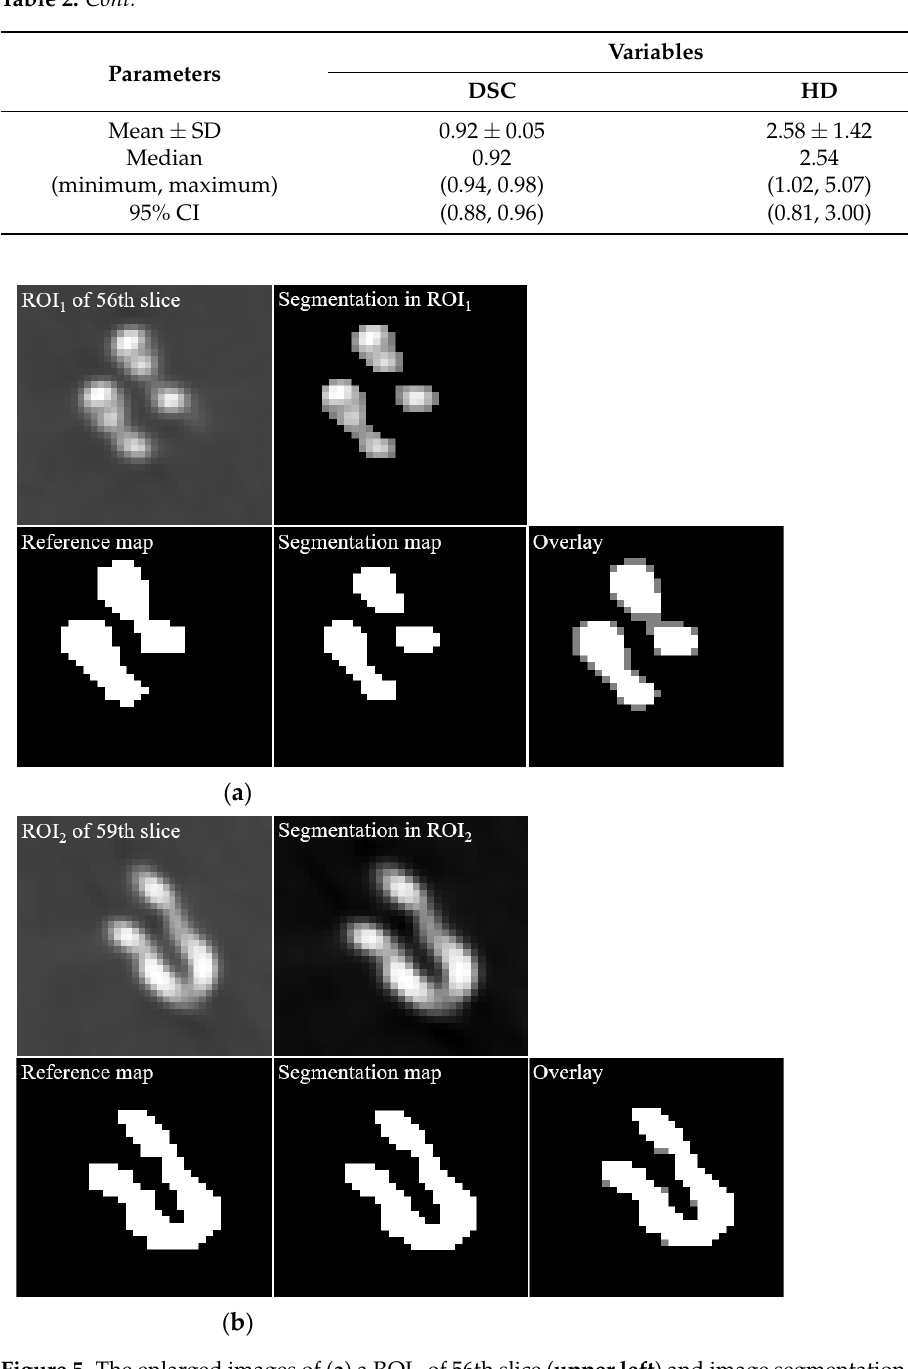
Figure 5. The enlarged images of ( a ) a ROI 1 of 56th slice ( upper left ) and image segmentation in ROI 1 ( upper middle ) represent the complete results of clip segmentation, a reference map ( bottom left ), a segmentation map ( bottom middle ) using the proposed method, and an image overlay (bottom right) of both reference and segmentation maps. ( b ) These are also the resultant images in ROI 2 of 59th slice as ( a ). Table 2. Dice similarity coefficient (DSC) and Hausdorff distance (HD) descriptive statistics are shown in Figure 5.